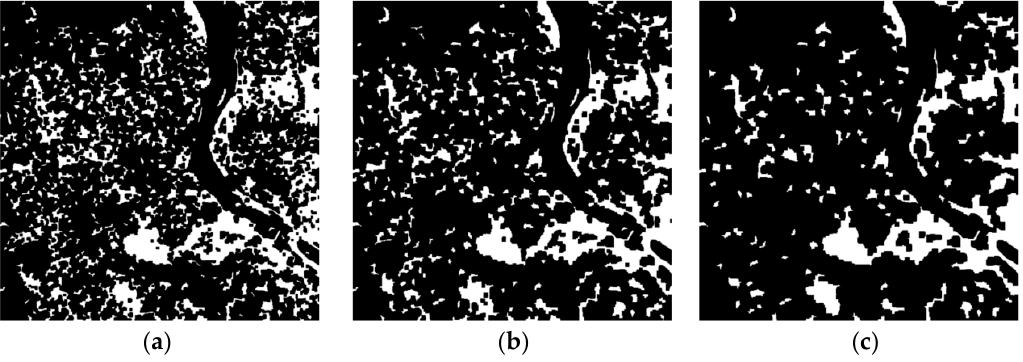
Figure 13. Image differencing results between normalized subject image generated by NC and reference image: ( a ) noise reduction using SLIC 5 × 5; ( b ) noise reduction using SLIC 7 × 7; and ( c ) noise reduction using SLIC 9 × 9.